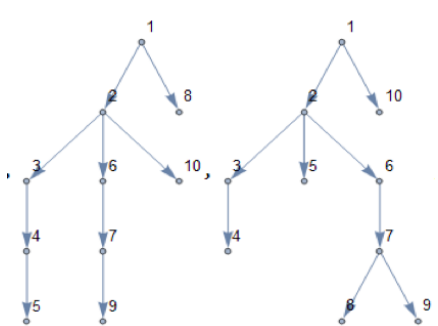
Figure 3. O ff spring chromosomes a) and